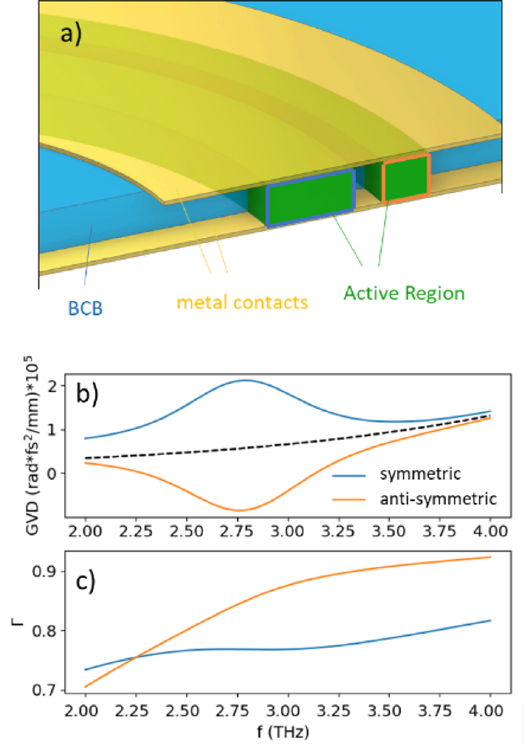
Figure 1. a) Schematic representation of a coupled waveguide ring laser. b) Group velocity dispersion of the symmetric (blue trace) and anti-symmetric (orange trace) super-modes of a cou- pled waveguide ring laser. The black dotted line represents the GVD of the bare GaAs. c) Overlap factor ( Γ ) of the symmetric (blue trace) and anti-symmetric (orange trace) supermode. Both GVD and Γ are computed with 2D axisymmetric simulations per- formed with Comsol